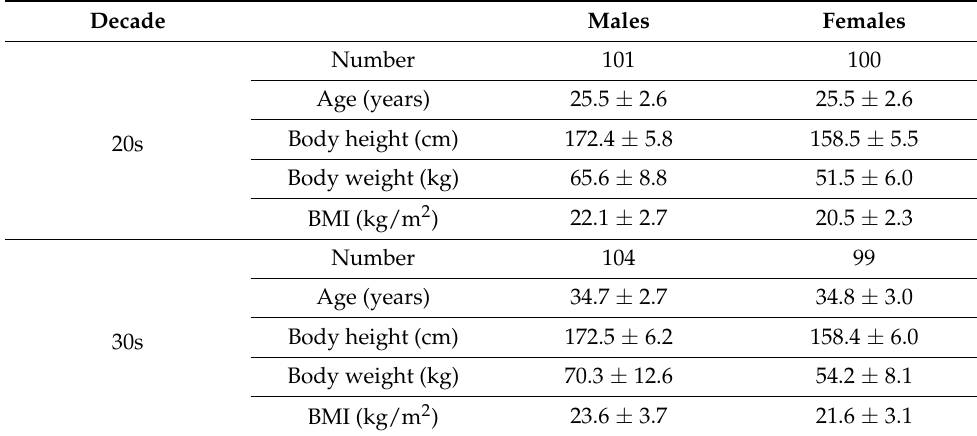
Table 1. Demographics of asymptomatic subjects between decades or